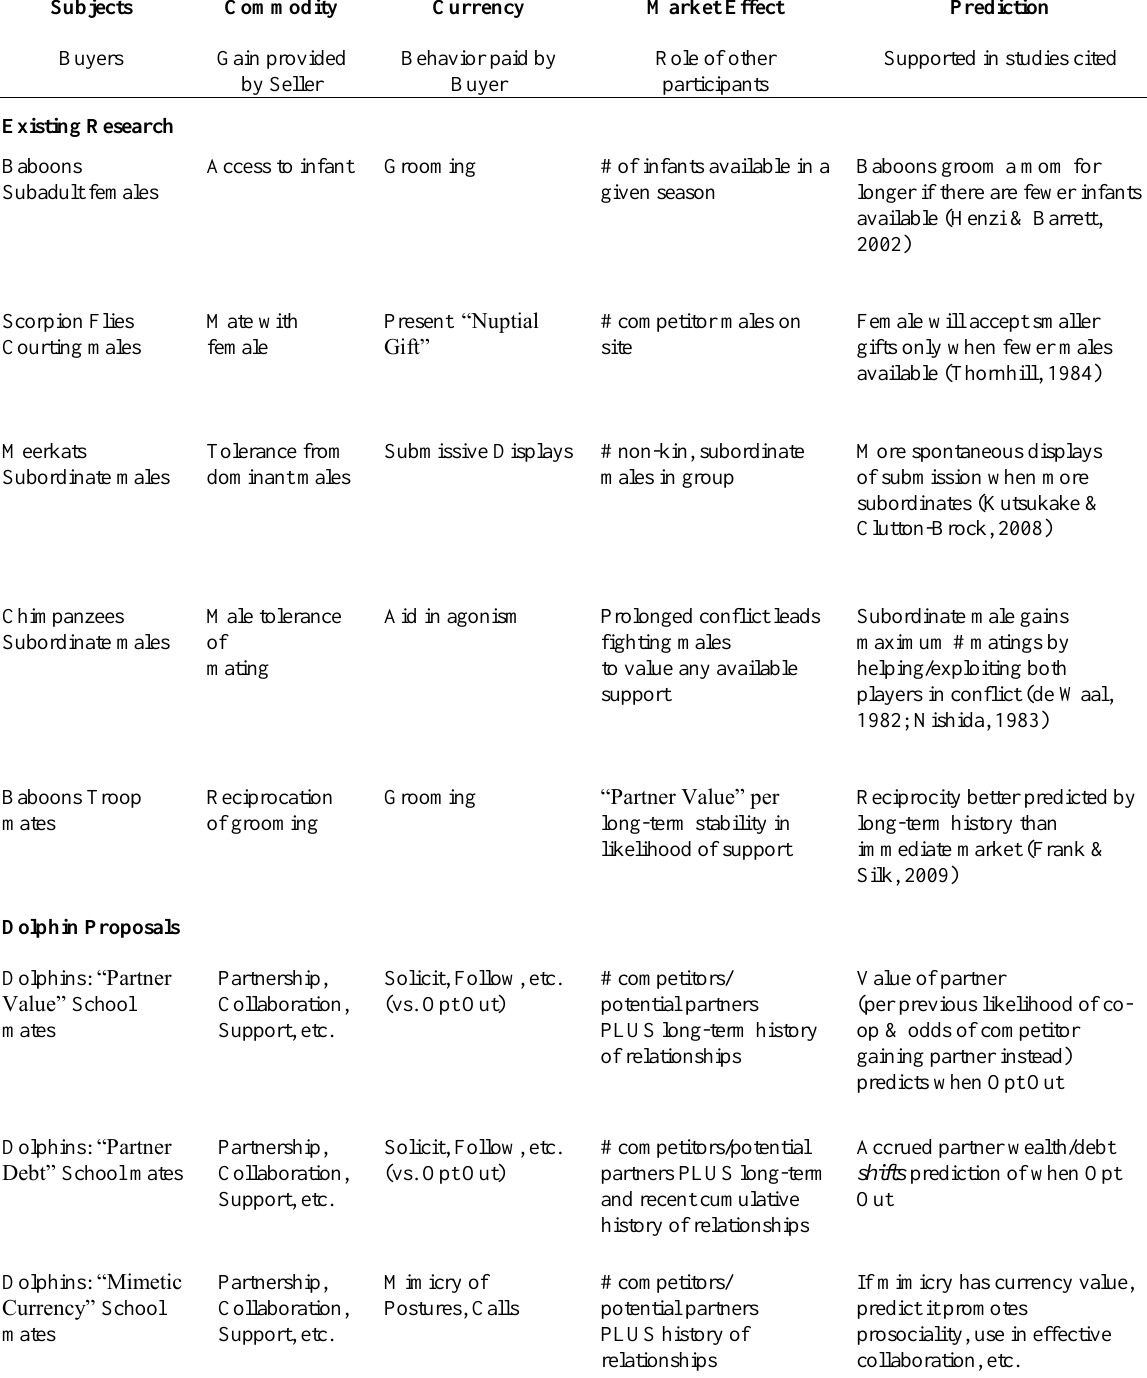
Components of market models, including predictions of tested and proposed